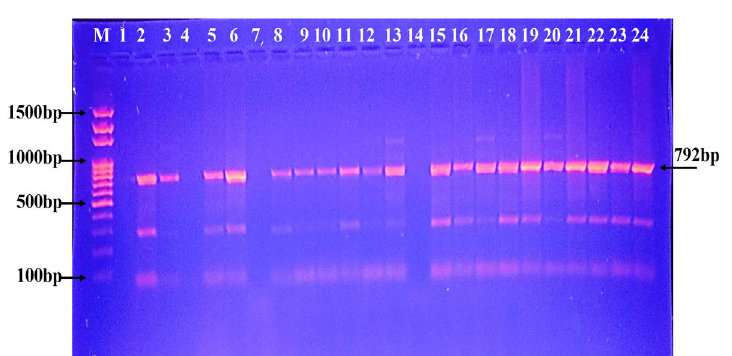
Fig. 3. Agarose gel electrophoresis of the bla 1500-100bp. Other lanes: positive amplification,